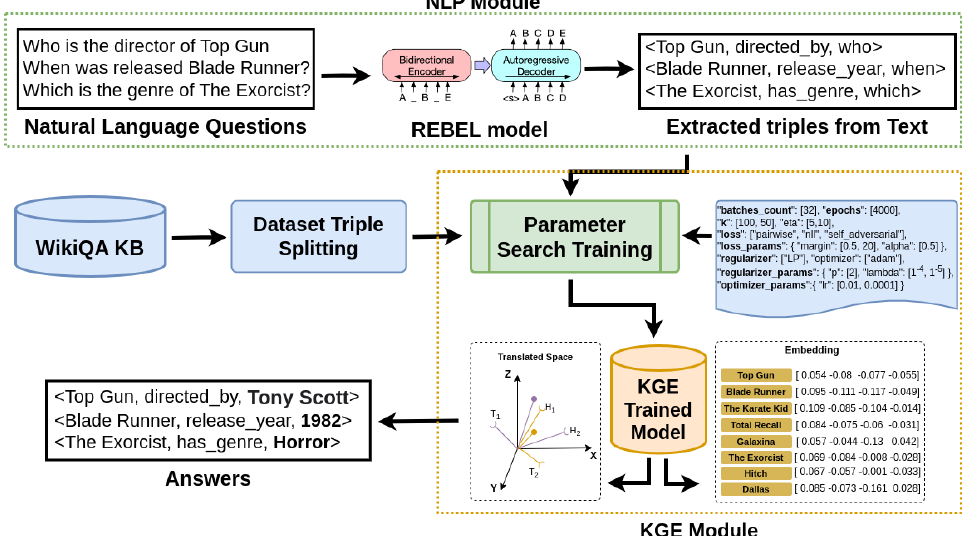
Figure 2. Overview of the proposed system: The first module, REBEL, takes a natural language question as input. The textual question is then processed by REBEL, which returns a <s,p,o> triple, whose object (o) represents one of the five possible question types. The extracted triple is given as input to the KGE module. The KGE model interprets relationships as translated operations on low- dimensional embeddings. Once the translated space is obtained, the model compares the distances between subject + predicate with object embedding features to verify if subject + relation = object . If the distance is lower than a threshold, the fact is considered reliable and true, and the triple has been completed successfully. The output given by TransE consists of the triple containing the correct